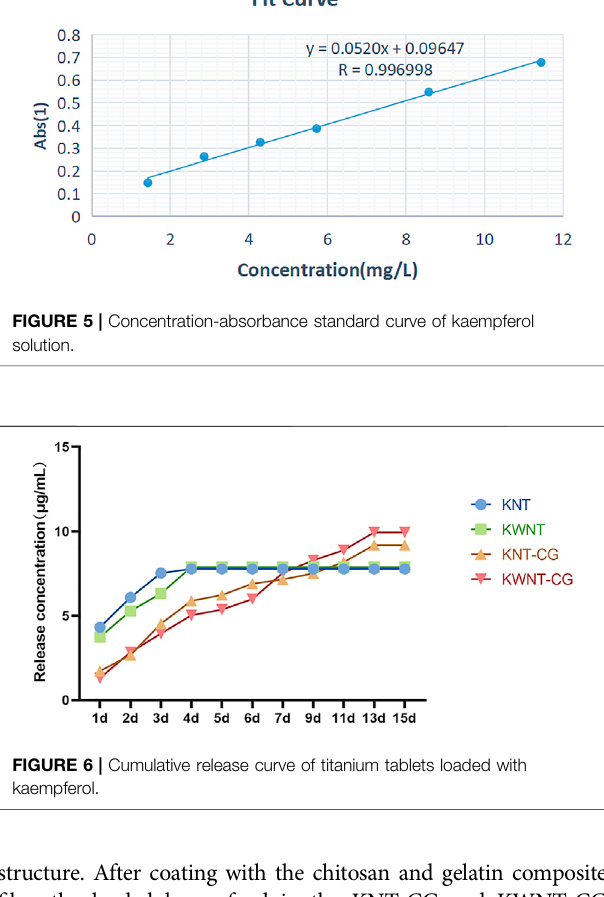
Frontiers in Bioengineering and Biotechnology |